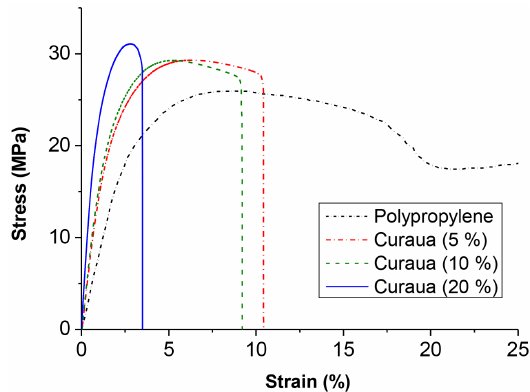
Figure 1. Average stress strain curves of polypropylene and biocomposites.